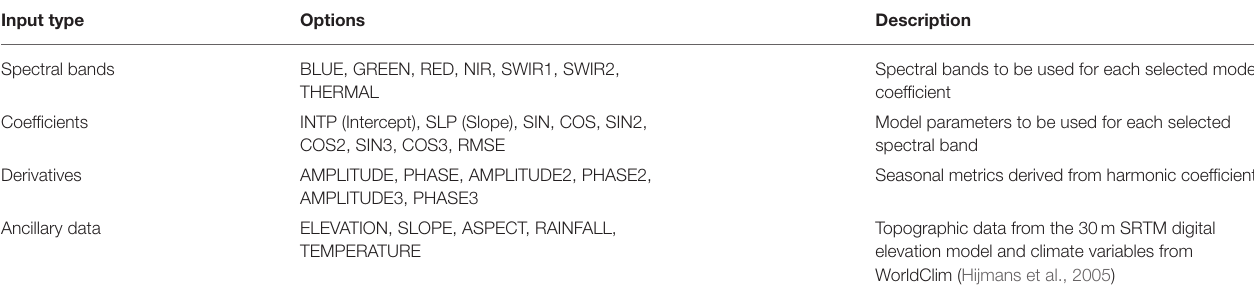
TABLE 1 | List of currently available predictors for classification in the graphical user interface tool when all the Landsat bands are